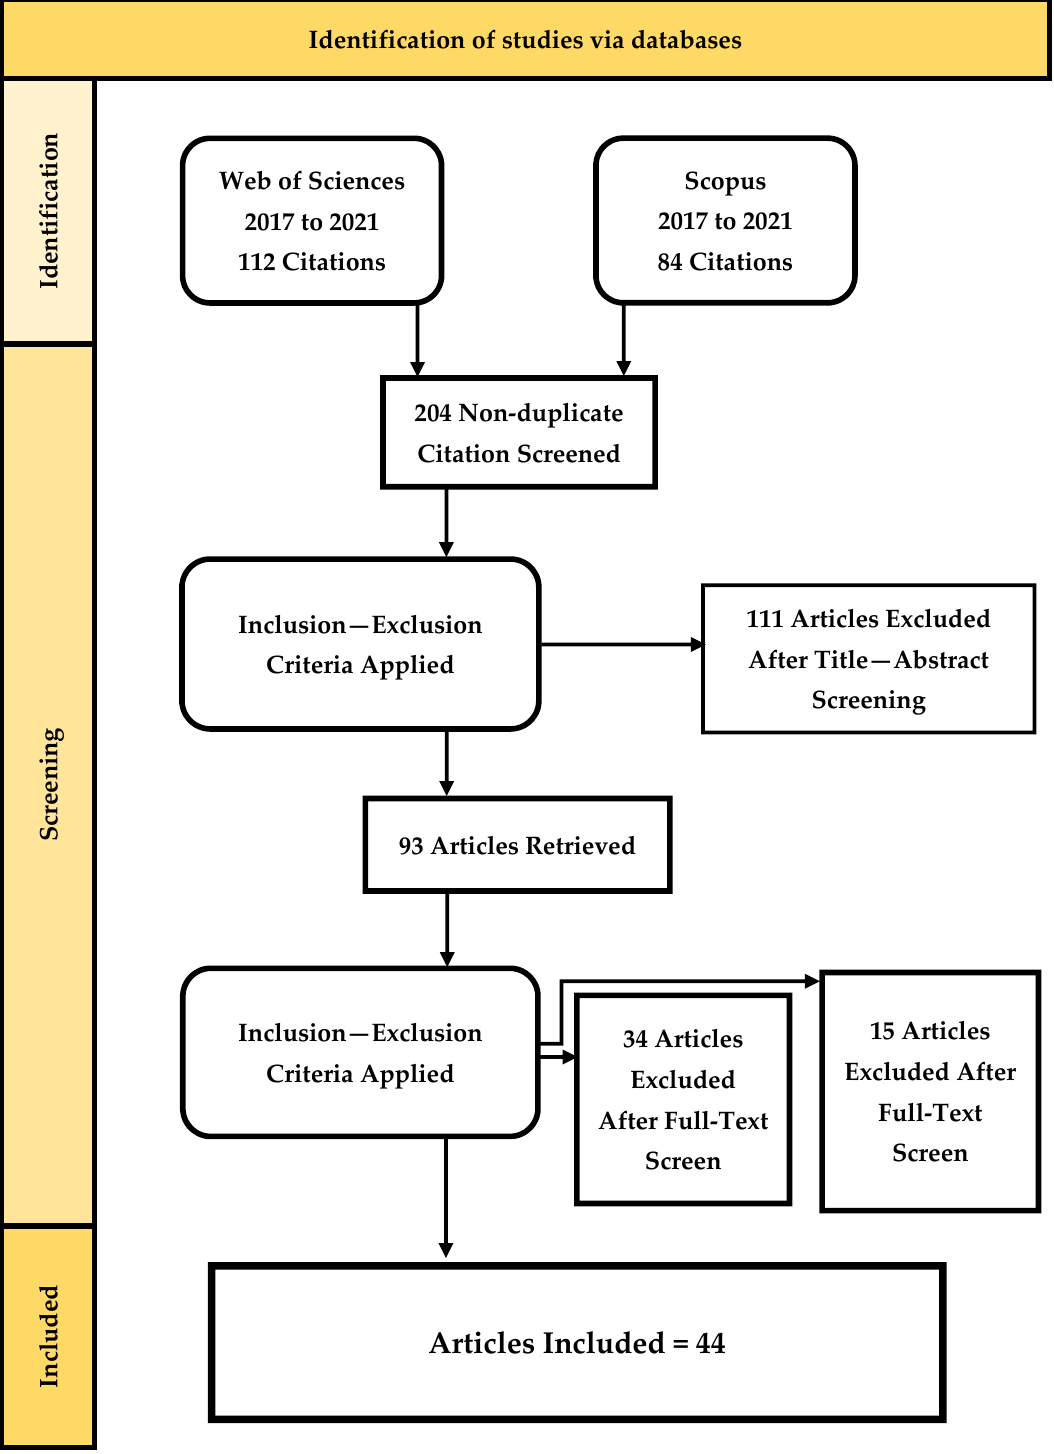
Figure 1. Flow Diagram for screening and management process. Note: This diagram depicts the whole screening and selection process of related studies used in analyzing the current literature review.